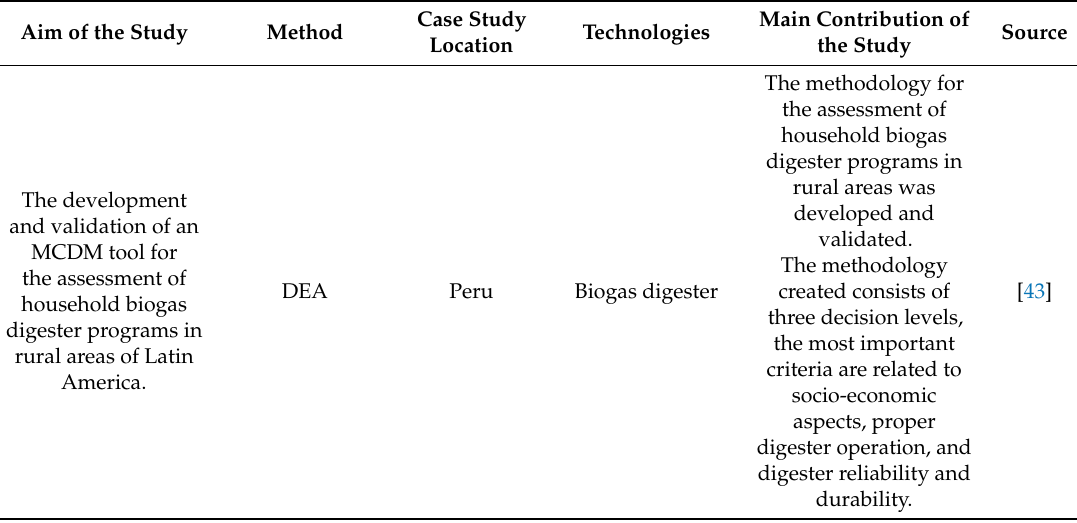
Table 4. Energy management problems